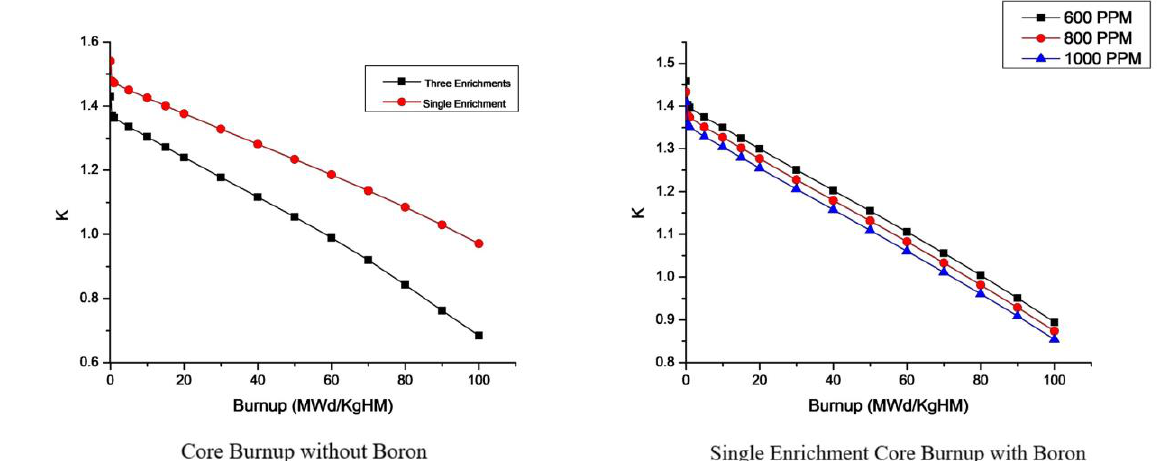
Figure 10. Full core burnup analysis.